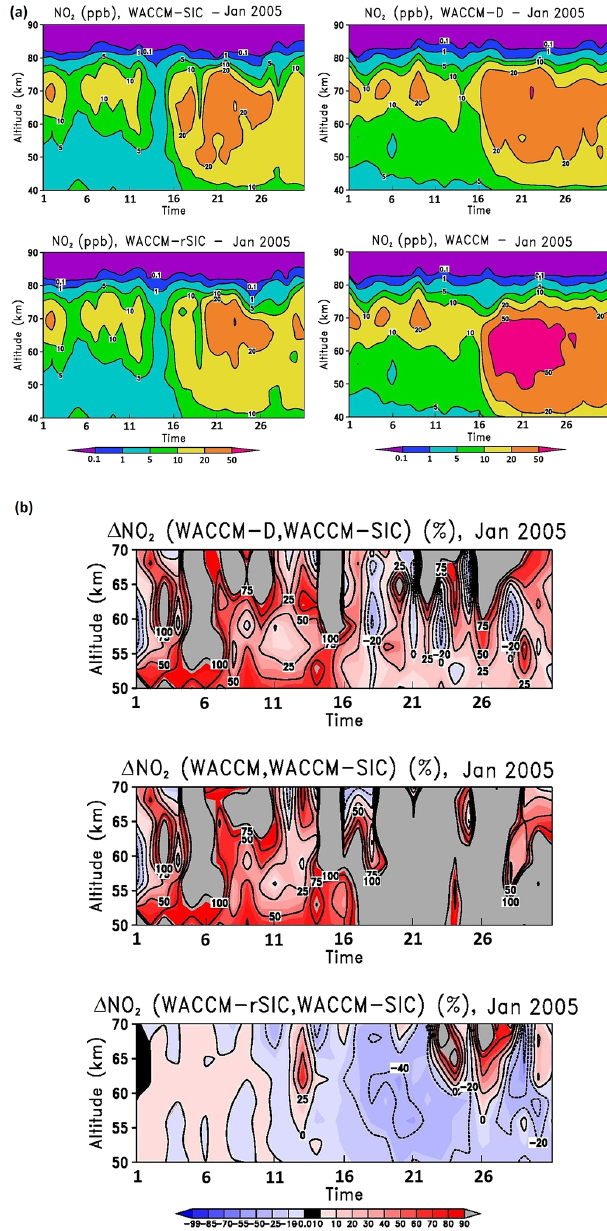
Figure 4. (a) Zonal mean vertical concentration profiles of mesospheric/upper-stratospheric NO (in ppb) for Northern Hemi- sphere polar latitudes (60–90 ◦ N) during January 2005; (b) percent- age difference between three models (WACCM-D, WACCM and WACCM-rSIC) and the full WACCM-SIC.